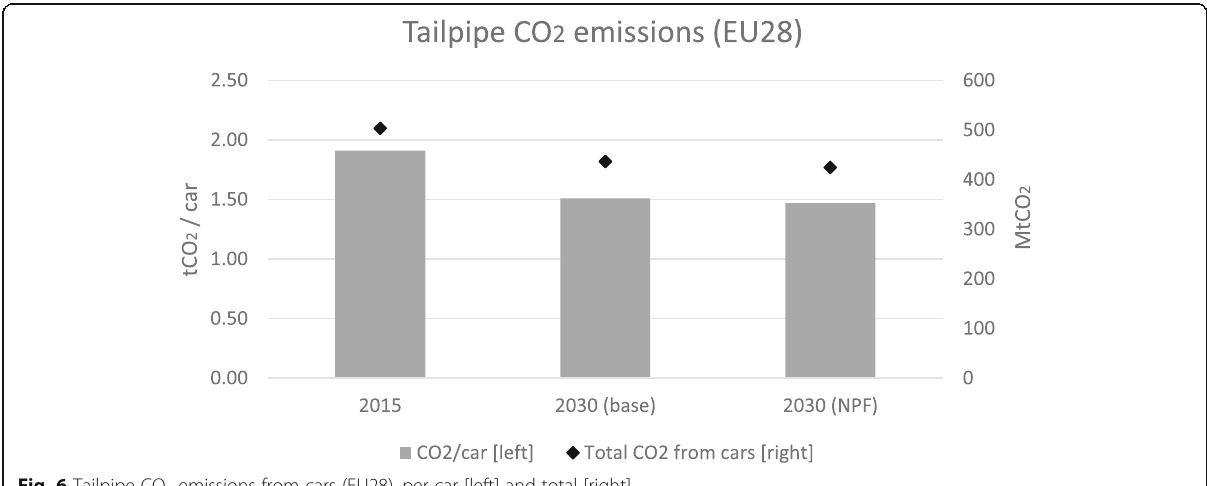
Fig. 6 Tailpipe CO 2 emissions from cars (EU28), per car [left] and total